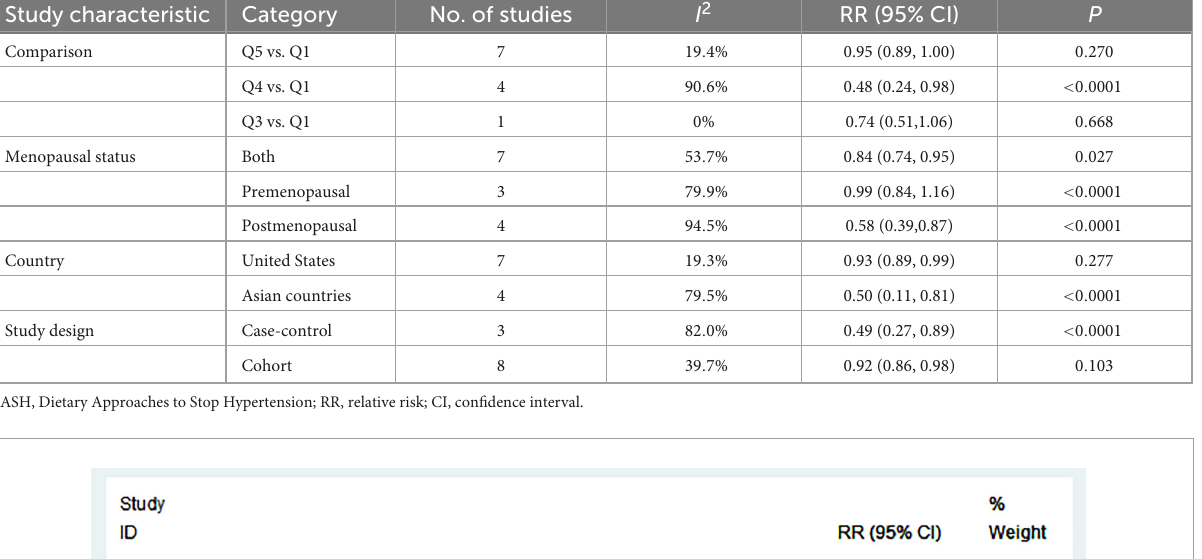
vs. Q1 comparison studies, there was no evidence of significant heterogeneity between studies ( P = 0.270, I 2 = 19.4%), and a marginally significant association between DASH diet and risk of breast cancer was shown (RR = 0.95; 95% CI: 0.89–1.00; P =